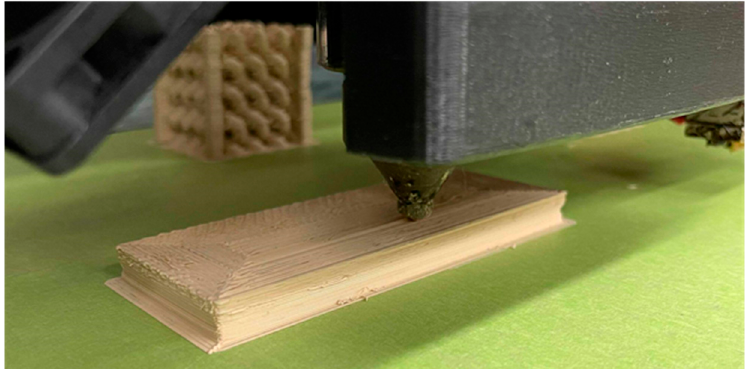
Figure 2. Rectangular slab produced to characterize the permittivity of the material.